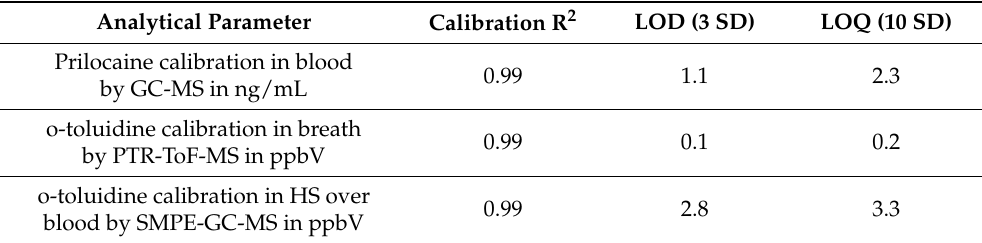
Table 1. Analytical parameters for prilocaine detection in blood by means of GC-MS, o-toluidine detection in breath by means of PTR-ToF-MS and o-toluidine detection in the HS over blood by means of SPME-GC-MS. LOD = limit of detection; LOQ = limit of quantification; R 2 = correlation coefficient of calibration curve. Analytical Parameter Calibration R 2 LOD (3 SD) LOQ (10 SD) Prilocaine calibration in blood 0.99 1.1 2.3 by GC-MS in ng/mL o-toluidine calibration in breath 0.99 0.1 0.2 by PTR-ToF-MS in ppbV 0.99 blood by SMPE-GC-MS in ppbV